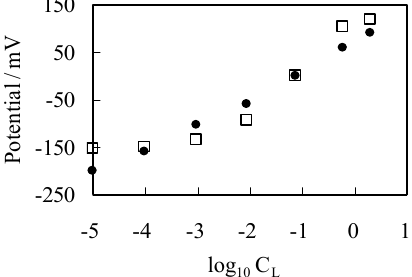
Figure 6. ×: potential generated between two KCl solutions using a separator of Ag wire vs. log C (=log [Cl − ] ); □ : computational potential ∆ϕ based on the adsorption theory vs. 10 L 10 L C (=log [Cl − ] ); Data represented by • in this diagram is created by rearranging the log 10 L 10 L data in Figure 3 represented by the same mark •.